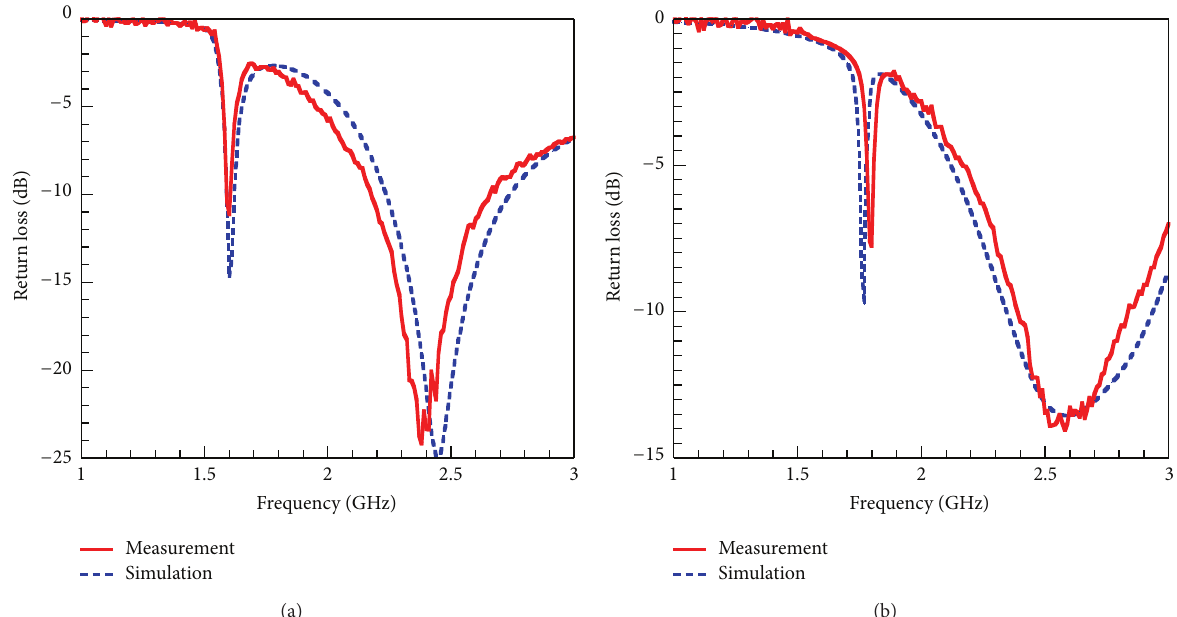
Figure 11: Comparison between simulated and measured return losses for the designed antenna with a coupling distance 𝑑 1 : (a) configuration A1 ( 𝑑 1 = 4 mm); (b) configuration A2 ( 𝑑 1 = 1 mm).